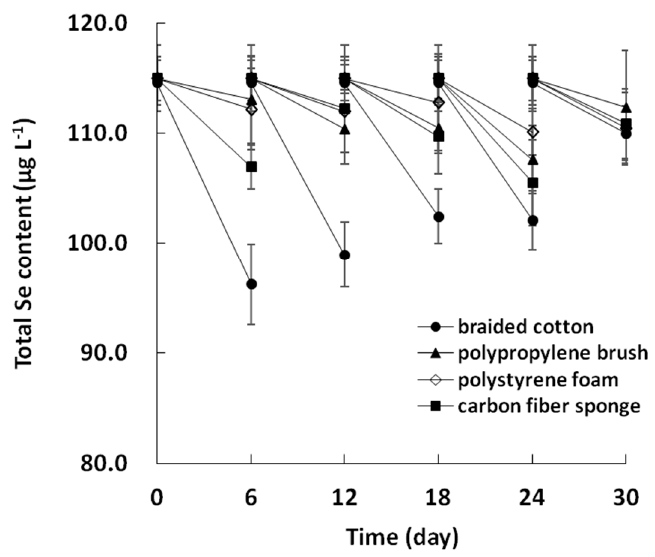
Figure 5. Total selenium concentration in the bioremediation test with different biofilm carriers (Error bars represent the standard deviation, N = 2).